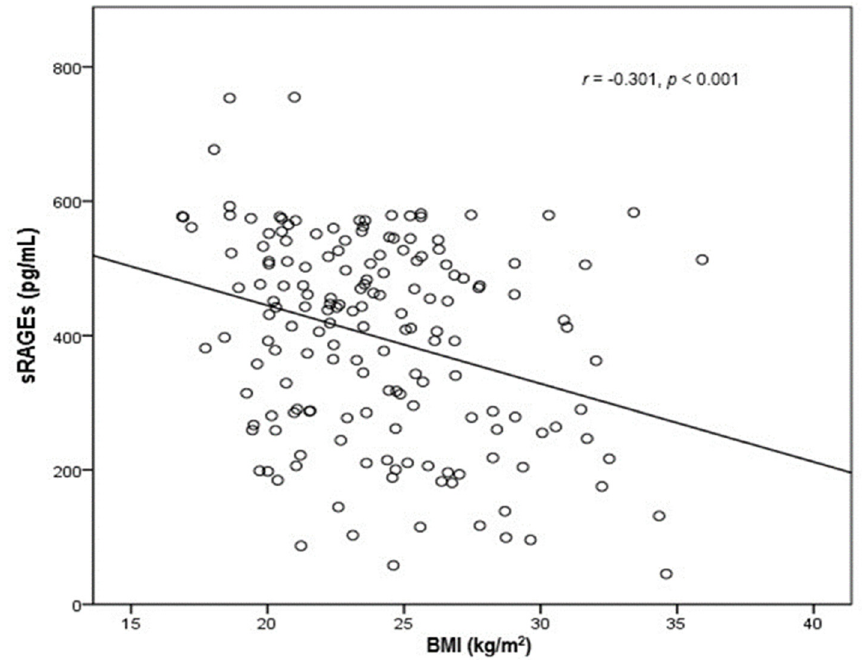
Figure 2. Scatterplot graph showing a negative relationship between baseline sRAGE levels and BMI. n = 166. Table 2. Biomarkers’ levels before and after exercise according to